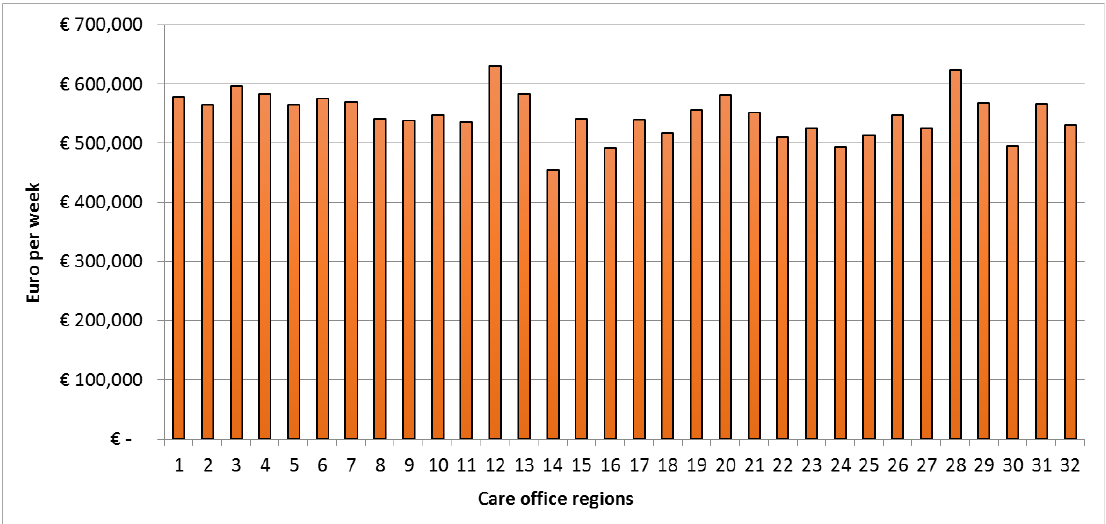
Average care intensity per week for the total amount of publicly financed home care entitlements per care office